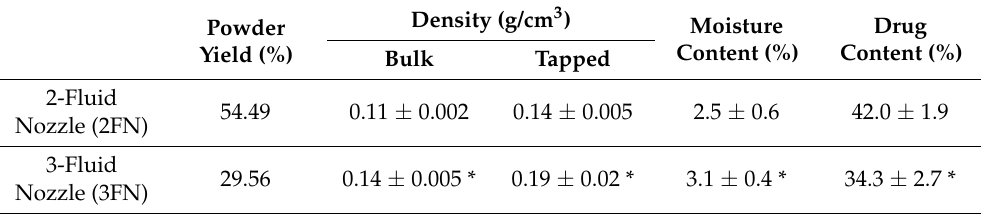
Table 1. Physicochemical properties of spray-dried powders (Mean ± SD, n = 3, * p < 0.05).